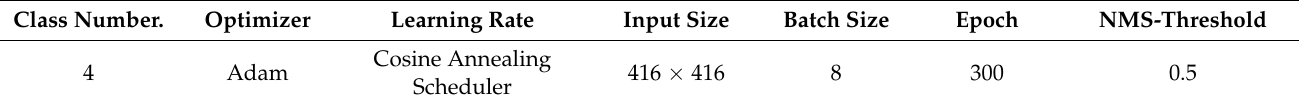
Table 3. Experimental configuration.